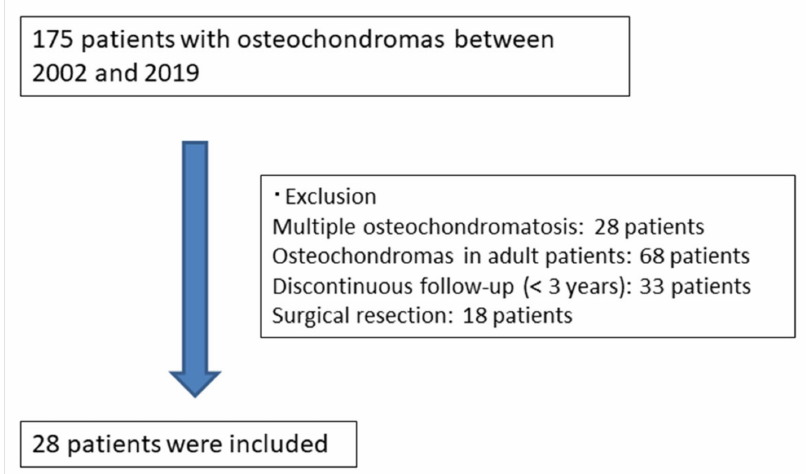
Figure 1. The patients’